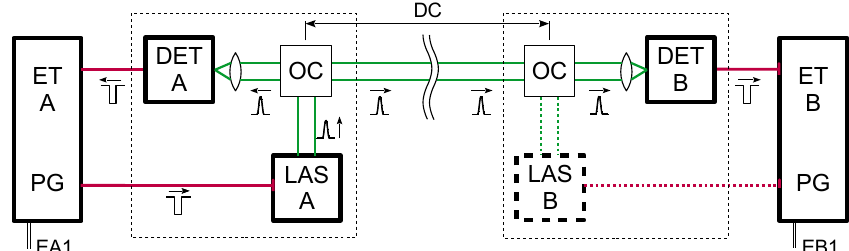
Fig. 1 Block scheme of optical two-way time transfer. Red lines stand for electrical signal lines, green lines stand for optical signal paths. The first measurement phase when module A is generating optical signals is displayed. Two event timers ET A and ET B are equipped with identical optical modules. The event timers represent the time scales A and B . Each optical module consists of an optical signal combiner OC , laser optical source LAS and a photon counting detector DET . These modules are interconnected by an optical channel: free space in our case. The measurement is carried out in two phases. First the laser LAS A is generating an ultrashort optical pulse. It is split by a signal combiner OC A and is propagating in both directions toward DET A and DET B . They are detected by these detectors and time tagged in the respective time scales A and B . The corresponding epochs are recorded and stored. In the second phase the laser LAS B is generating ultrashort uniform pulse, which is split and propagating toward both detectors DET A and DET B . The corresponding epochs are recorded. Two pairs of epochs can be combined producing the time difference DS between the two time scales along with the delay of the optical channel DC interconnecting the two optical modules. Reference points are defined symmetrically inside each optical signal combiner with picosecond